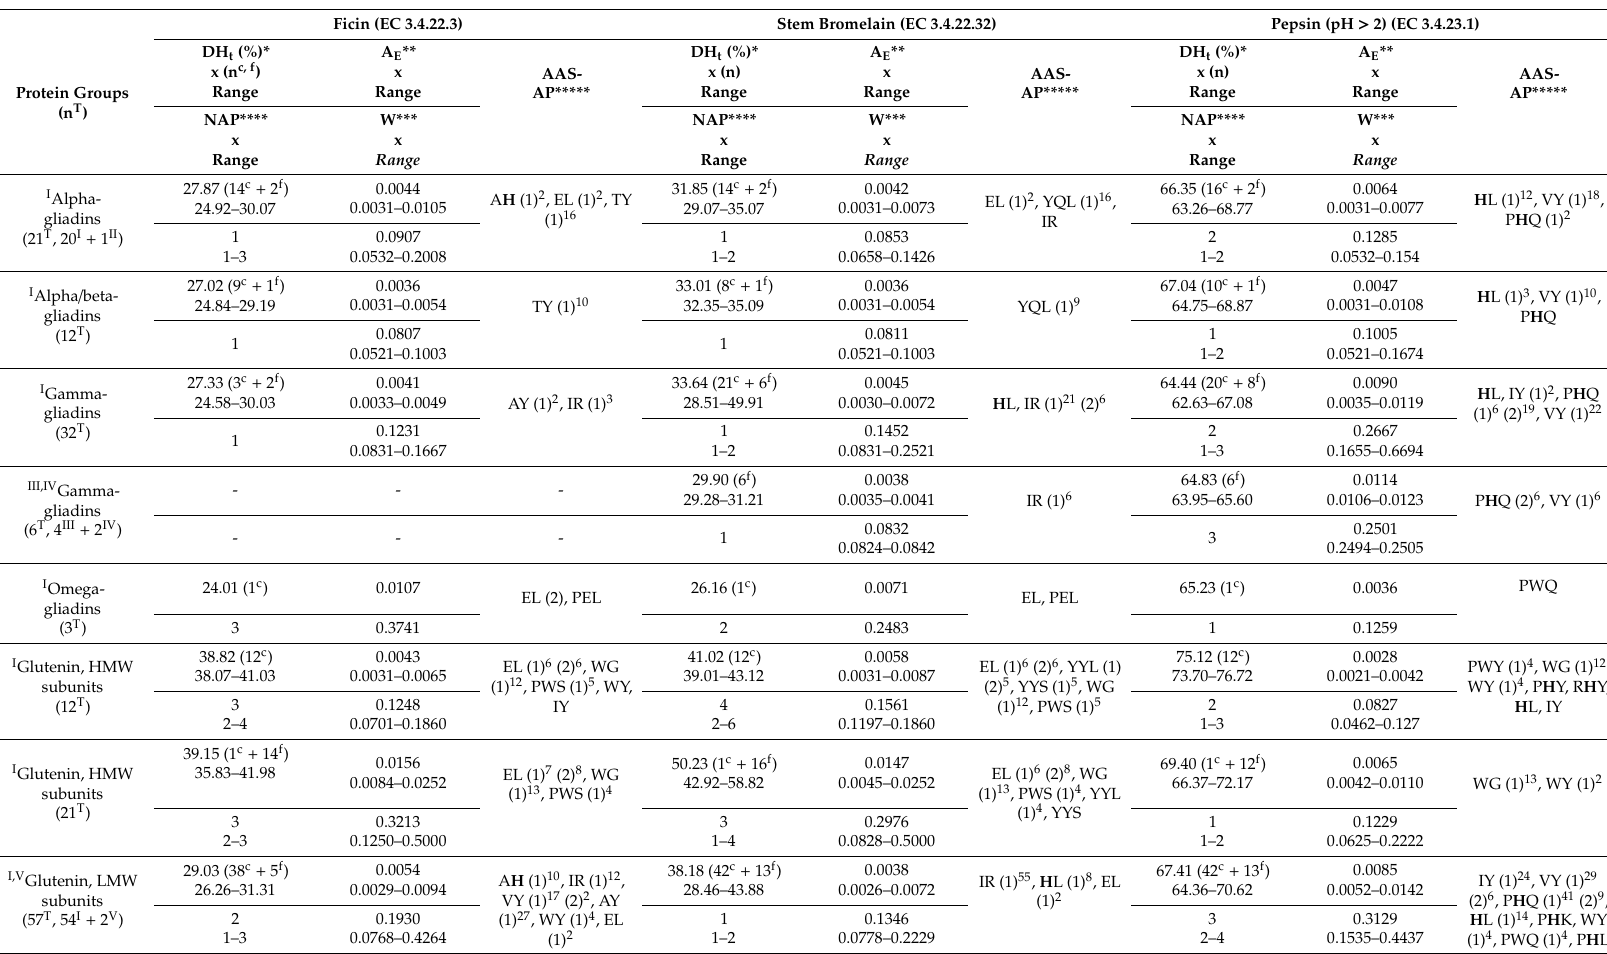
Table 6. The bioparameters characterising the in silico hydrolysis of wheat proteins ( I Triticum aestivum, II Triticum aestivum subsp. Spelta, III Triticum aestivum spp. sphaeroccoum, IV Triticum aestivum spp. compactum, V Triticum aestivum spp. tibeticum, VI Triticum turgidum subsp. durum) and the molecular characterisation of the obtained antioxidant